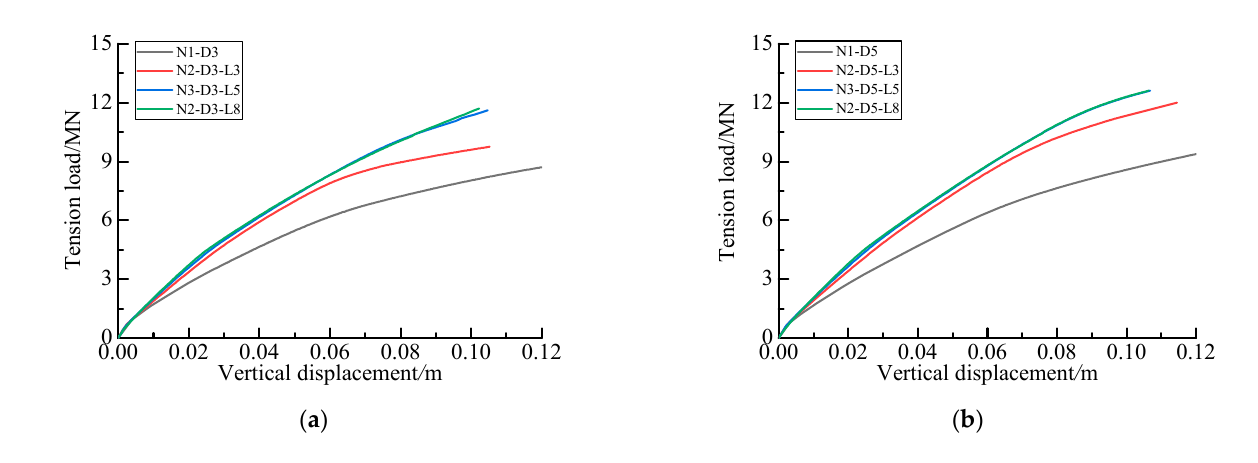
Figure 28. Uplift load-displacement curves for various blade spacing l/ D . ( a ) D / d = 1.5, n = 2; ( b ) D / d = 2.5, n = 2. Table 9. Uplift efficiency coefficient for various blade spacing l/ D .